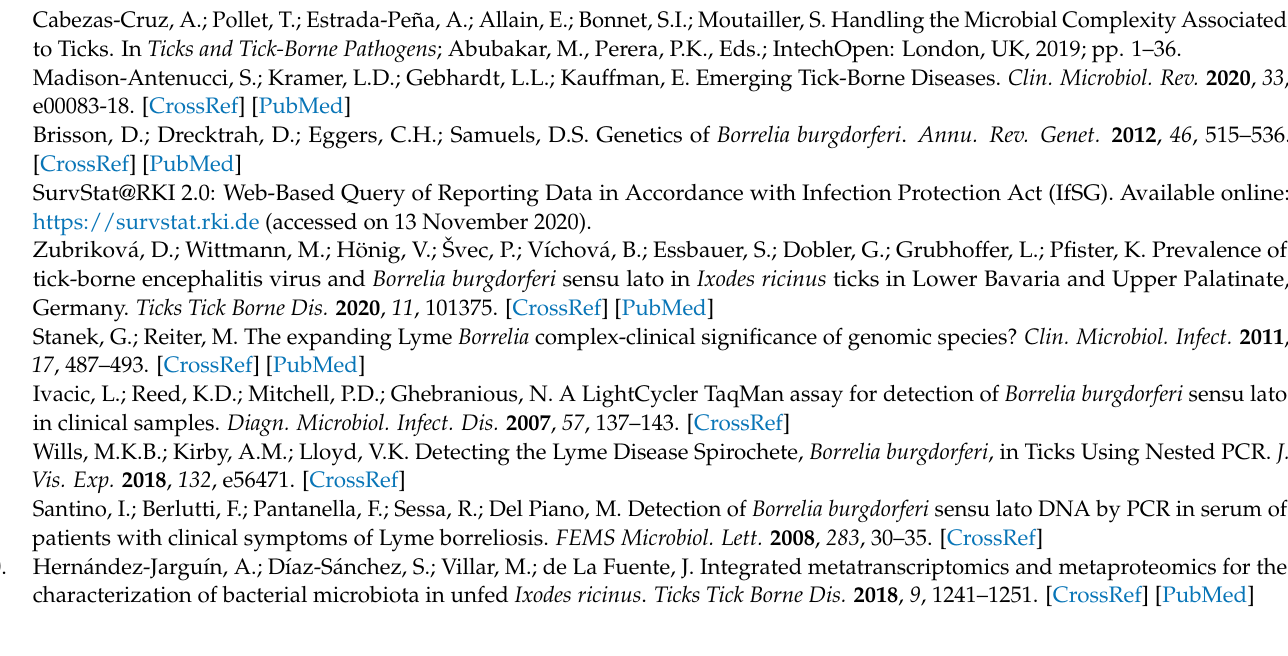
(WN; n = 56). Green lines indicate co-occurrence links, while red lines indicate mutual exclusion links. The different colors of the squares with the bacterial genera indicate different cluster membership, Figure S24: Interaction of Stenotrophomonas in the Borrelia -positive tick microbiome from Weiden (WP; n = 44). Green lines indicate co-occurrence links, while red lines indicate mutual exclusion links. The different colors of the squares with the bacterial genera indicate different cluster membership, Table S1: OTU count table, and OTU count table summarized on genus level, Table S2: OTU count table summarized on genus level with the relative sequence read abundance and topological role in the network of Borrelia -negative and -positive ticks from Esslingen and Weiden, respectively, Table S3: OTU diversity indices from the tick-borne Borrelia -negative (EN, n = 62; WN, n = 56) and Borrelia - positive microbiome (EP, n = 38; WP, n = 44) derived from Esslingen (E) or Weiden (W), Table S4: Parameters and topological roles from the tick-borne Borrelia -negative (EN; WN) and Borrelia -positive co-occurrence networks (EP; WP) derived from Esslingen (E) or Weiden (W). The EN, WN, EP and WP network consisted of 62, 56, 38 and 44 bacterial community compositions,